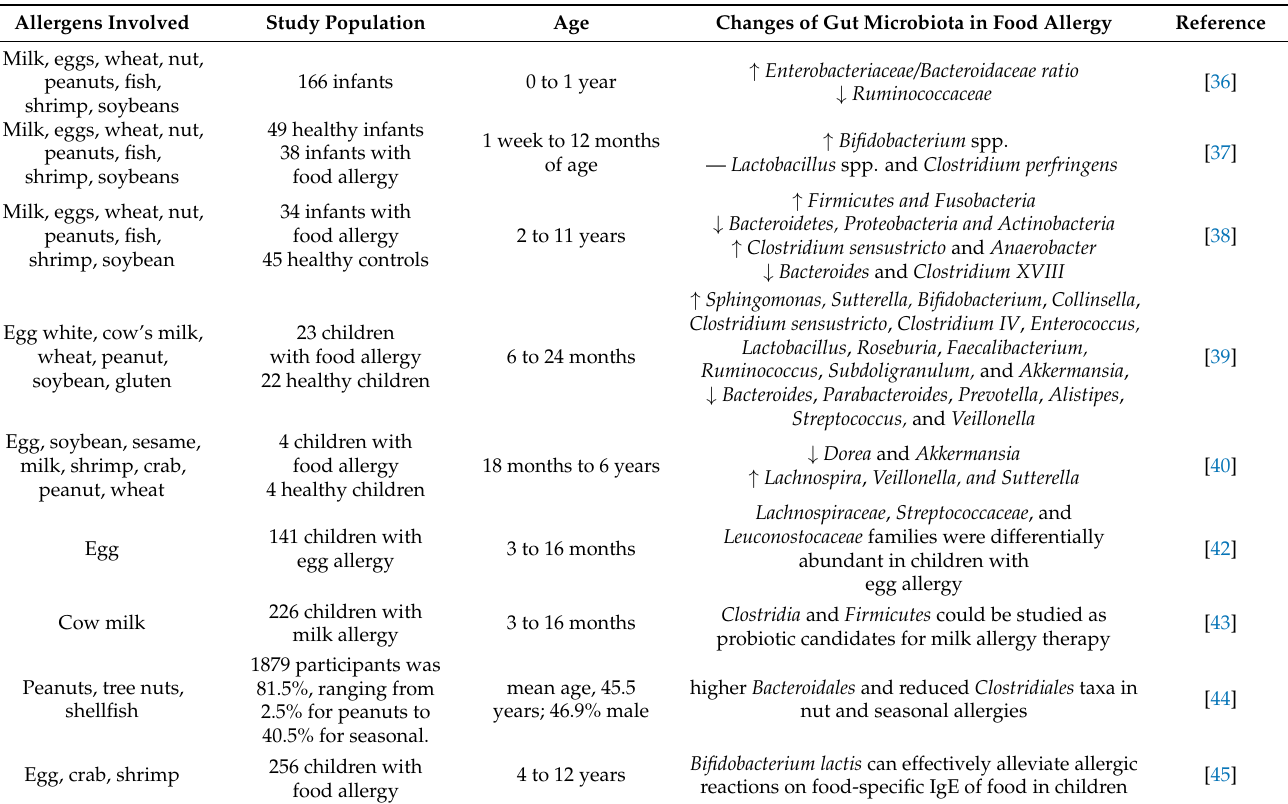
Table 1. Correlation of gut microbiota in human subjects’ association of food allergy ( ↓ : decrease; ↑ : increase; —: no